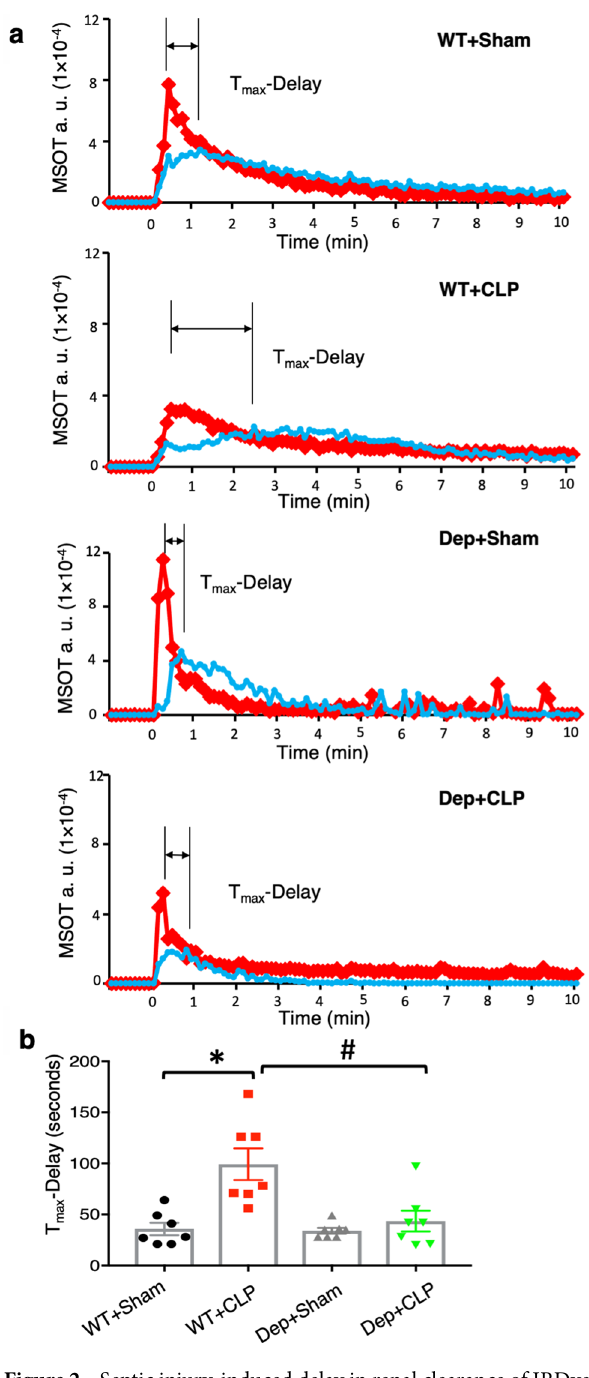
Figure 2. Septic injury-induced delay in renal clearance of IRDye800CW is significantly attenuated in Zdhhc21 dep/dep mice. ( a ) Representative IRDye800CW clearance kinetics of the cortex (red) and medulla/pelvis region (blue). Tmax-delay is the interval between the peaks of pixel intensity in cortex and medulla/pelvis region. ( b ) DHHC21 functional deficiency attenuates septic injury-induced increase in Tmax-delay. Results represent mean ± SEM. n = 7, *p ≤ 0.05 versus WT + Sham, # p ≤ 0.05 versus WT +